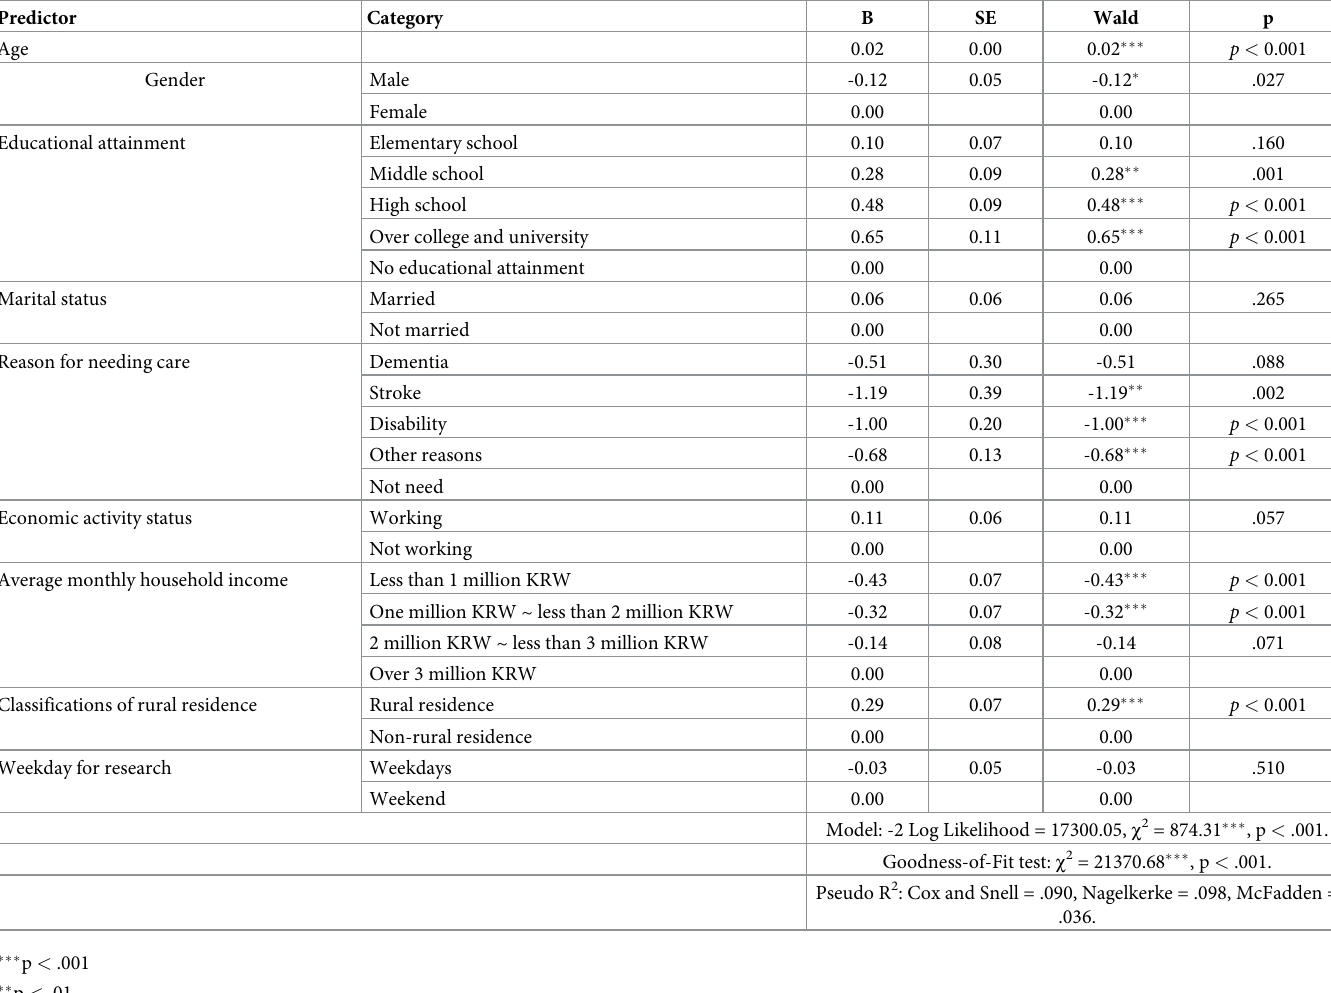
Table 3. Factors related to life satisfaction of occupational balance